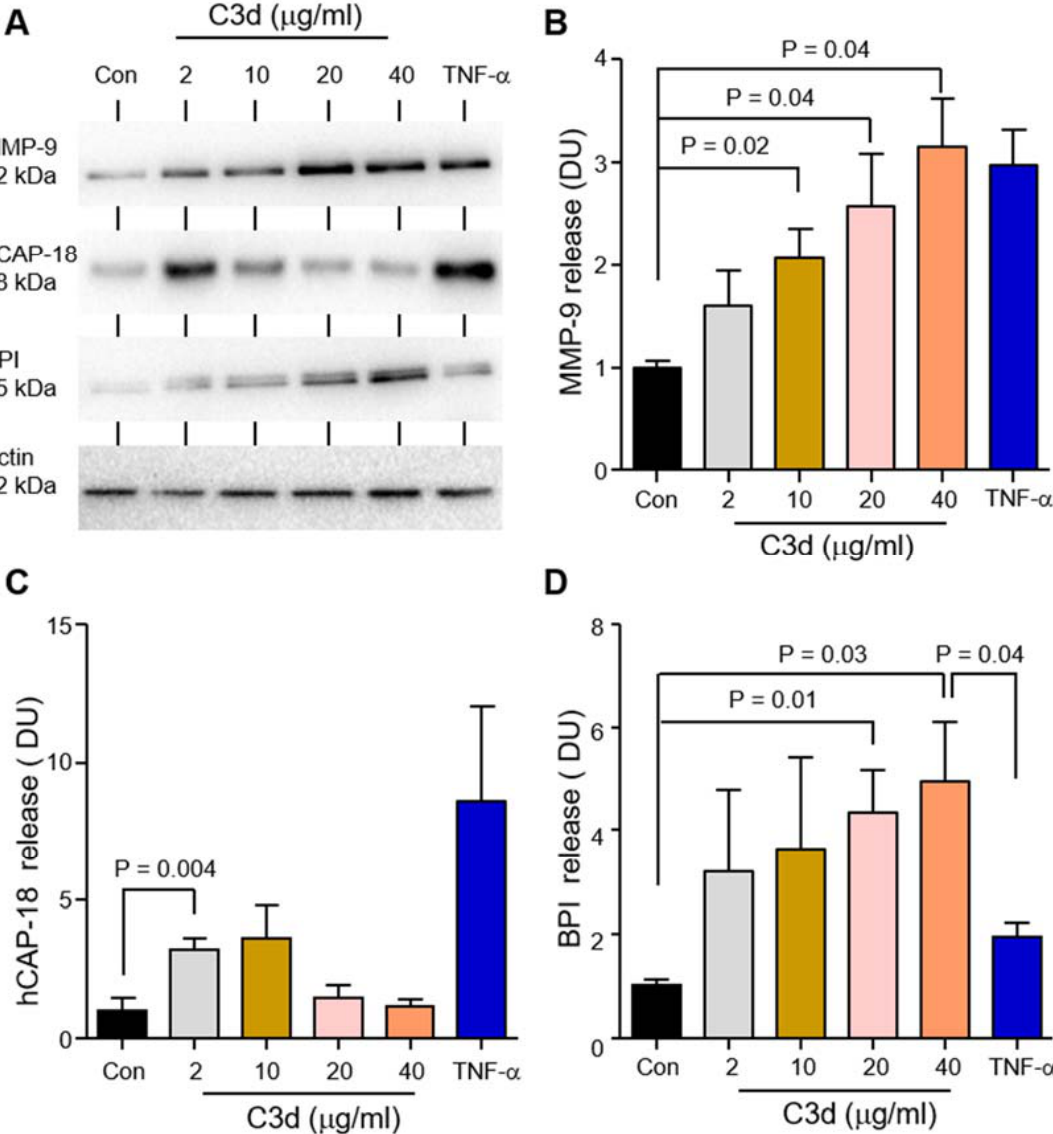
Figure 4. Neutrophil degranulation is increased in response to C3d treatment. Neutrophils isolated from HC individuals were incubated at 37 ◦ C and remained unstimulated (Con) or were stimulated with C3d (2–40 µ g/mL) or TNF- α (10 ng/2 × 10 7 cells) ( A – C ). ( A ) Cell-free supernatants were collected at 10 min and immunoblotted for markers of tertiary granule (MMP-9), secondary granule (hCAP-18), or primary granule (BPI) release. Densitometry of MMP-9 ( B ), hCAP-18 ( C ), and BLPI ( D ) immunobands was performed. Western blot analyses of whole cell lysates demonstrated equal expression levels of β -actin, confirming the use of equal cell numbers per reaction. C3d-challenged neutrophils released significantly greater levels of all three granule types when compared to untreated controls (Con) ( n = 5 biological repeats, ANOVA followed by Bonferroni post-hoc test for selected groups). All results are expressed as relative densitometry units (DU), with representative Western blots presented.